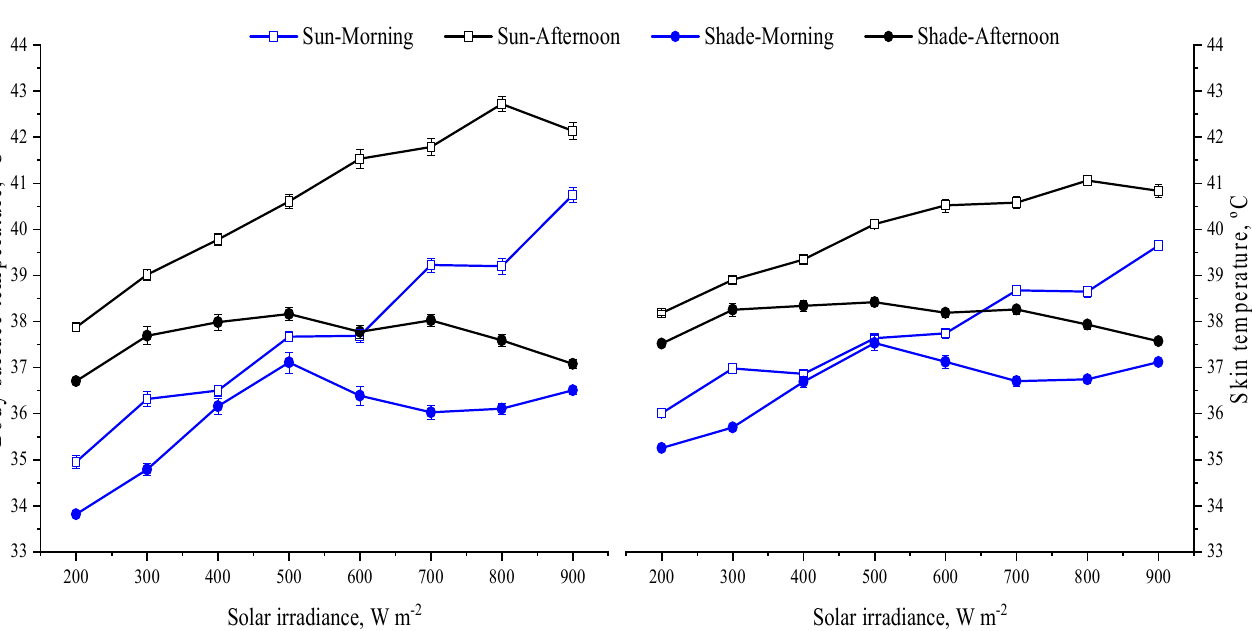
Figure 5. Least square means ( ± SEM) of body surface and skin temperatures of heifers when in shade and when exposed to sun.